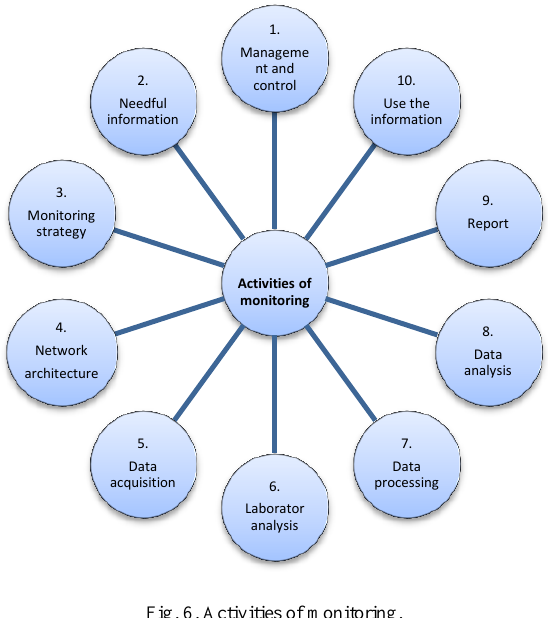
Fig. 6. Activities of